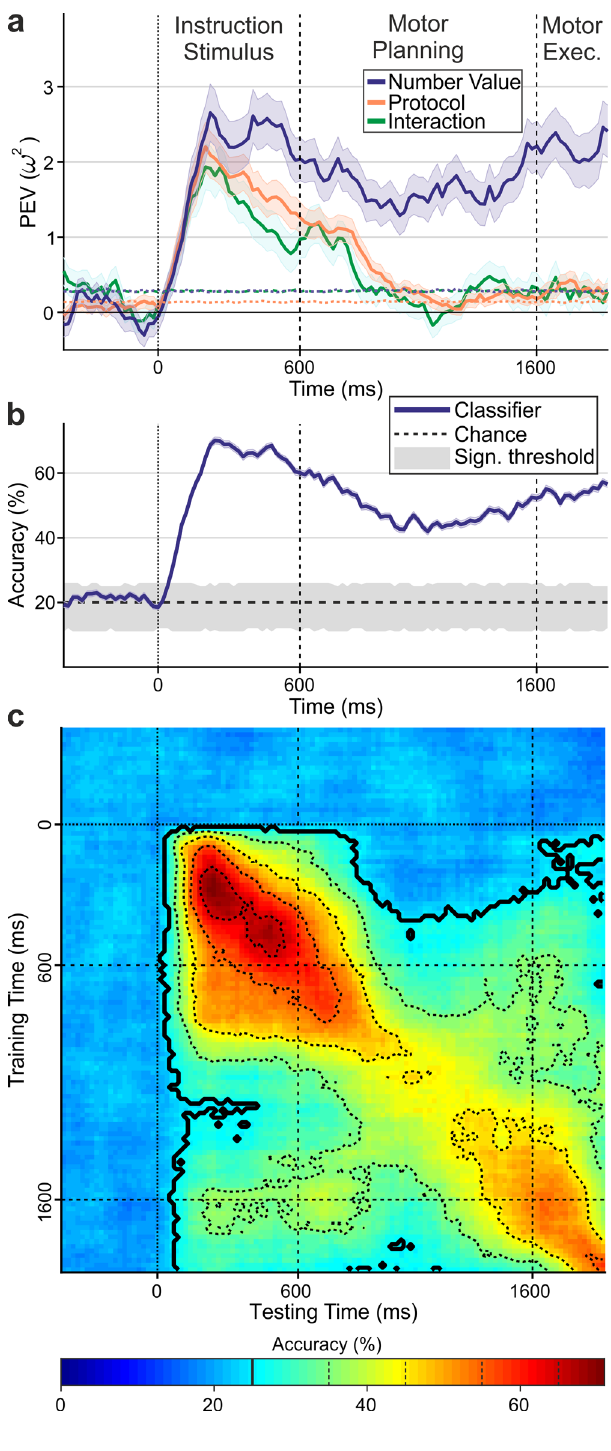
Fig. 6 | Distinct neuronal codes during sensorimotor transformation. a Information (expressed as time-resolved % explained variance; solid lines) about factors target number, instruction stimulus protocol, and their interaction carried by the neuron population across time. Dotted lines show percent explained var- iance for shuf fl ed trial labels, shaded areas the SEM over resamples. b Time- resolved SVM classi fi er performance. The solid line shows mean accuracy of clas- si fi er performance at each point in time during the trial (the mean diagonal accu- racy values derived from the cross-temporal confusion matrix shown in c , the purpleshaded area shows the SEM.The grayshaded areamarksthedistributionof shuf fl ed label classi fi er performance (5th to 95th percentile), whereas the dashed line shows the chance level for 5 classes. c Cross-temporal SVM classi fi er perfor- mance. Mean accuracy is color coded on the two-dimensional matrix, where training time bins are ordered along the y -axis, and testing time bins along the x - axis (temporally aligned to a and b ). Straight dotted lines mark the onset of the instructionstimulusperiodandstraightdashedlinesindicatethestartand theend of the motor planning period. The area outlined by the thick contour line corre- sponds to the temporal cluster of time bins signi fi cantly above chance level (~25%; cluster permutation test, see Methods for details). Dashed contour lines indicate different levelsofaccuracy (35 – 65%insteps of10%). Source data are provided asa Source Data fi